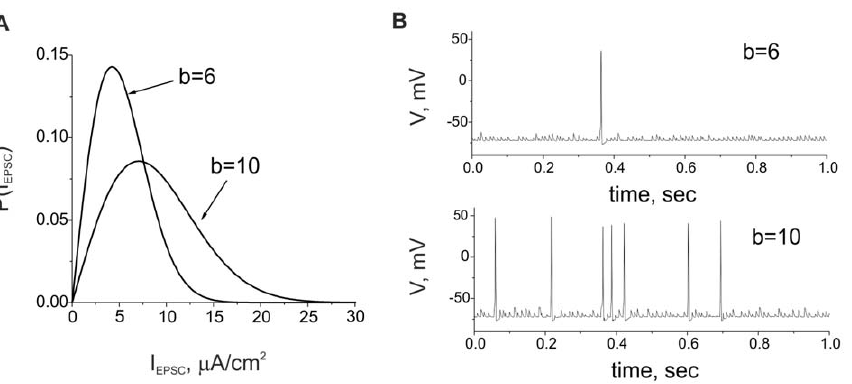
Figure 1. Neuron response to excitatory stimulation. A. Probability densities for EPSCs amplitudes according to Eq. (5) for b= 6 and b =10. B. Oscillations of membrane potential in Eqs. (1)–(5) for different strengths of synaptic input.